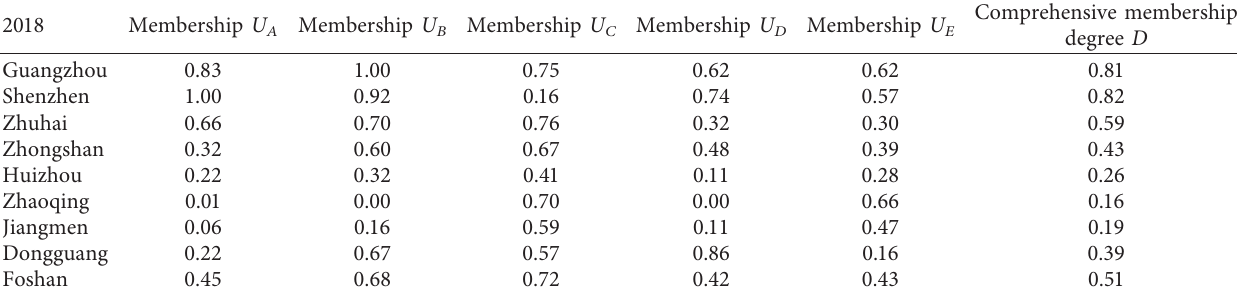
Table 17: First-level membership of the happiness index of nine cities in the Pearl River Delta in 2018.